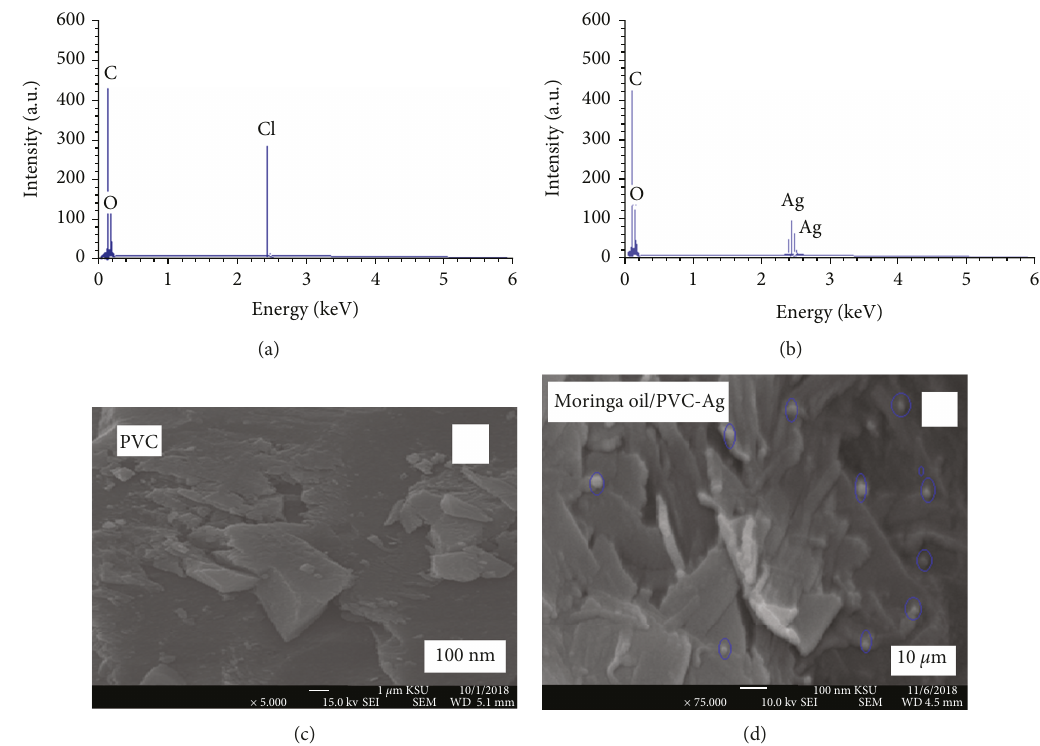
Figure 5: EDX spectra of (a) PVC and (b) Moringa oleifera oil/PVC-AgNPs. The image in (c) represents the SEM of PVC. The image in (d) represents the SEM of AgNPs in the Moringa oleifera oil/PVC-AgNP bionanocomposite.